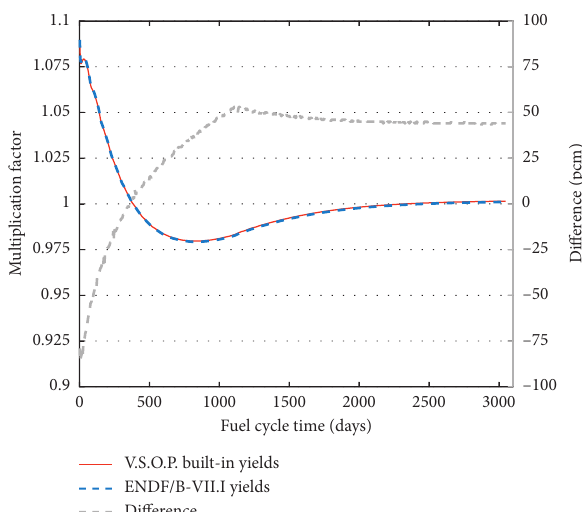
Figure 17: Multiplication factor predictions with operation time. Operation time involves a running-phase (0–2500 days) and equilibrium core state (3049 days). The multiplication factor prediction differences of V.S.O.P. built-in yields and ENDF/B-VII.1 posterior yields are